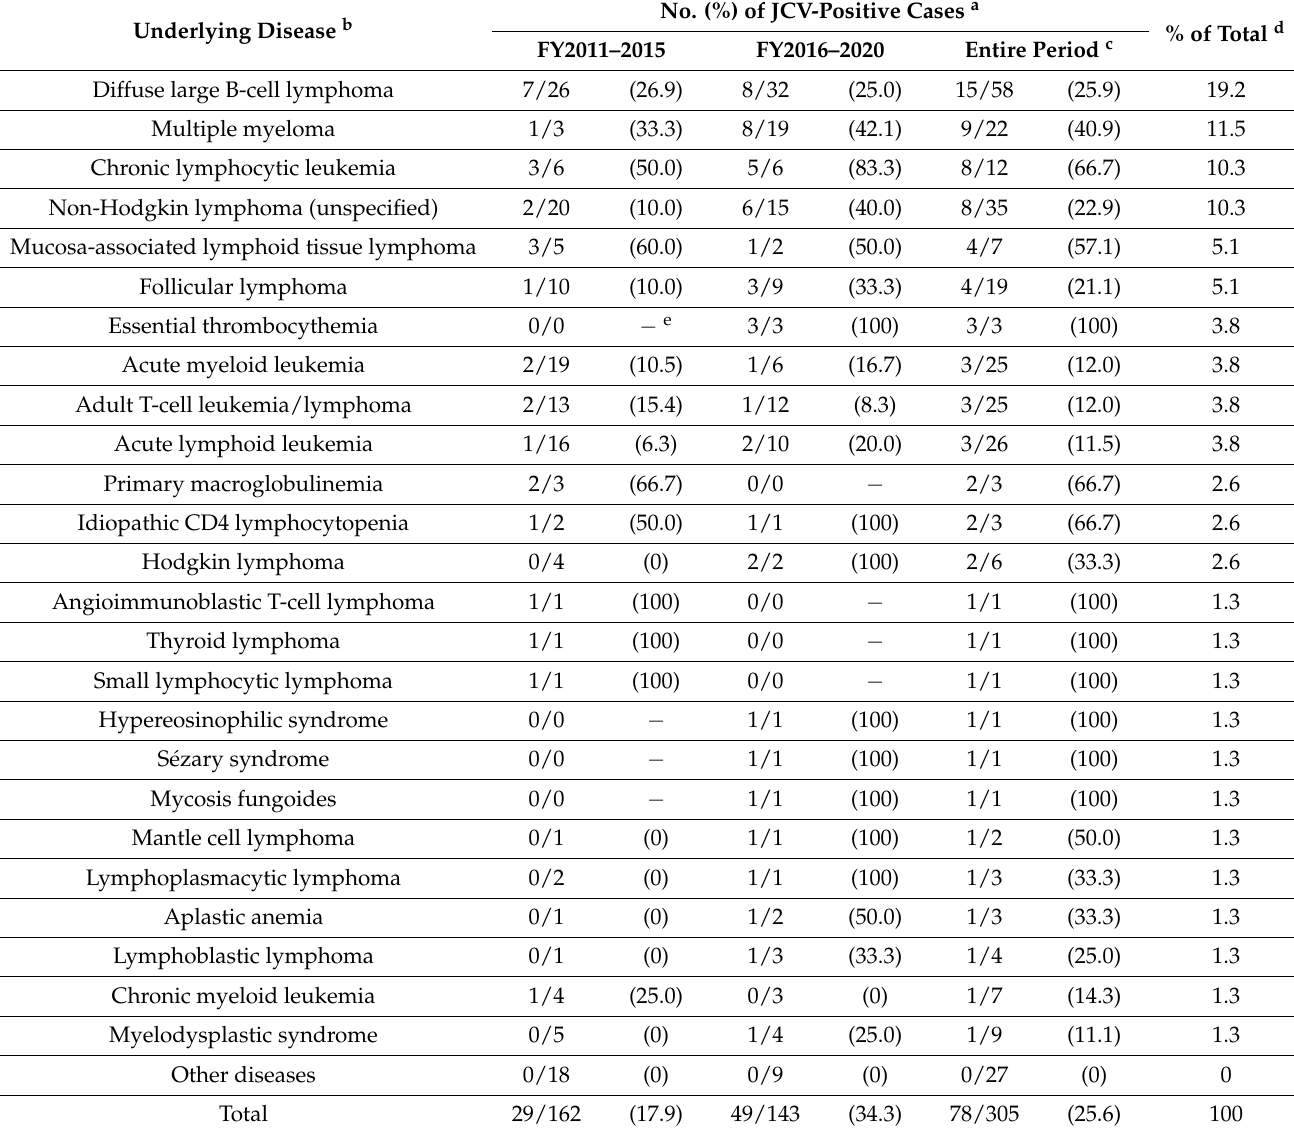
Table 2. PCR-based detection of JCV in CSF specimens from patients with hematological disorders. Underlying Disease